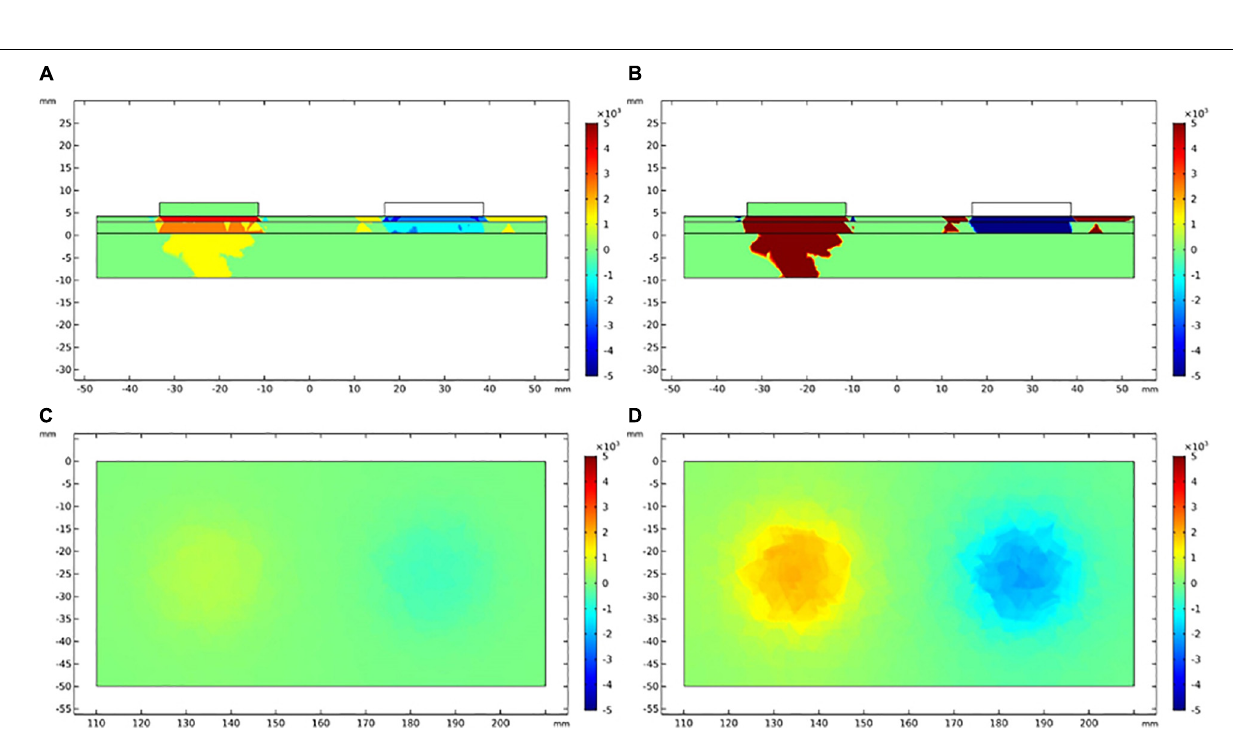
Frontiers in Neuroscience |